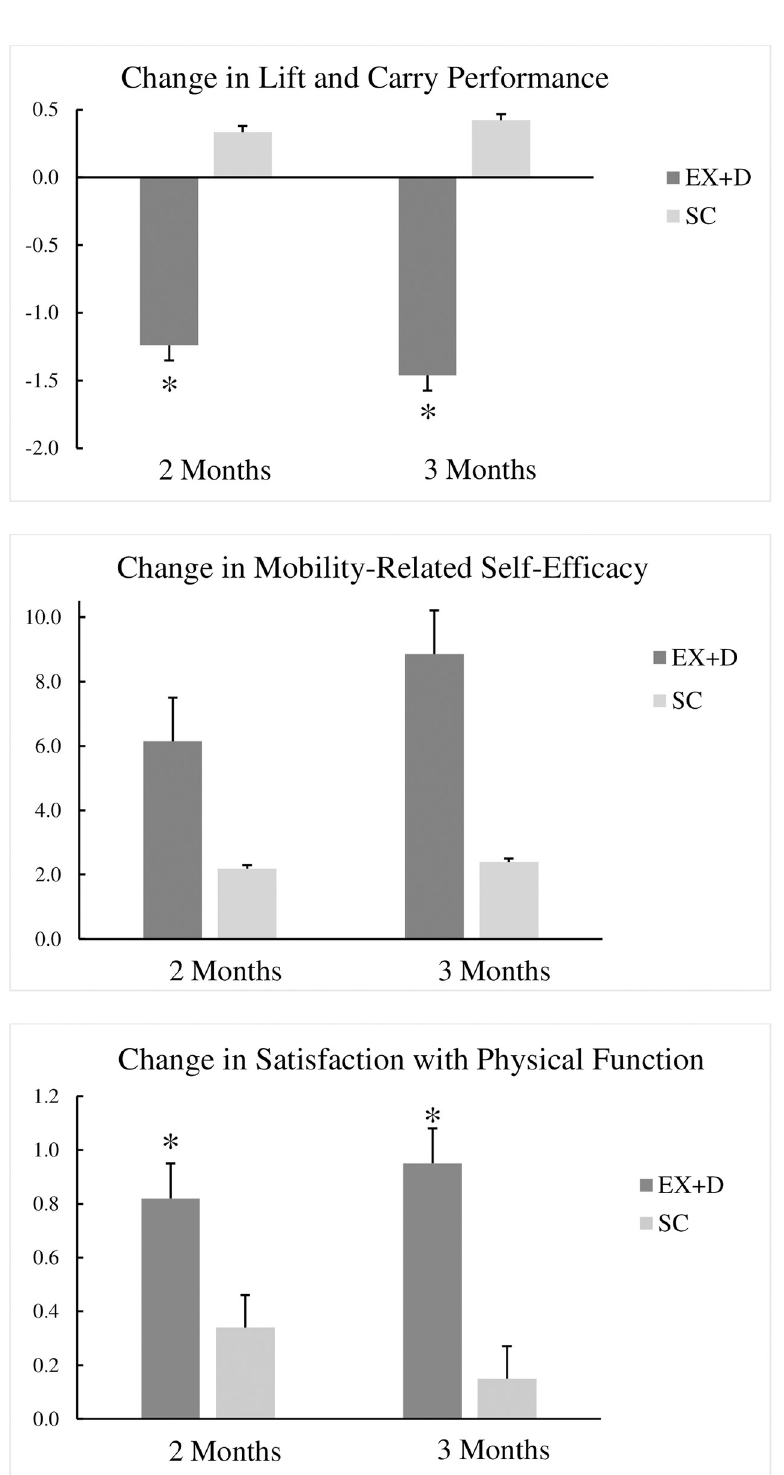
Fig 2. Adjusted mean changes ( ± SE) in lift and carry performance and social cognitive outcomes.